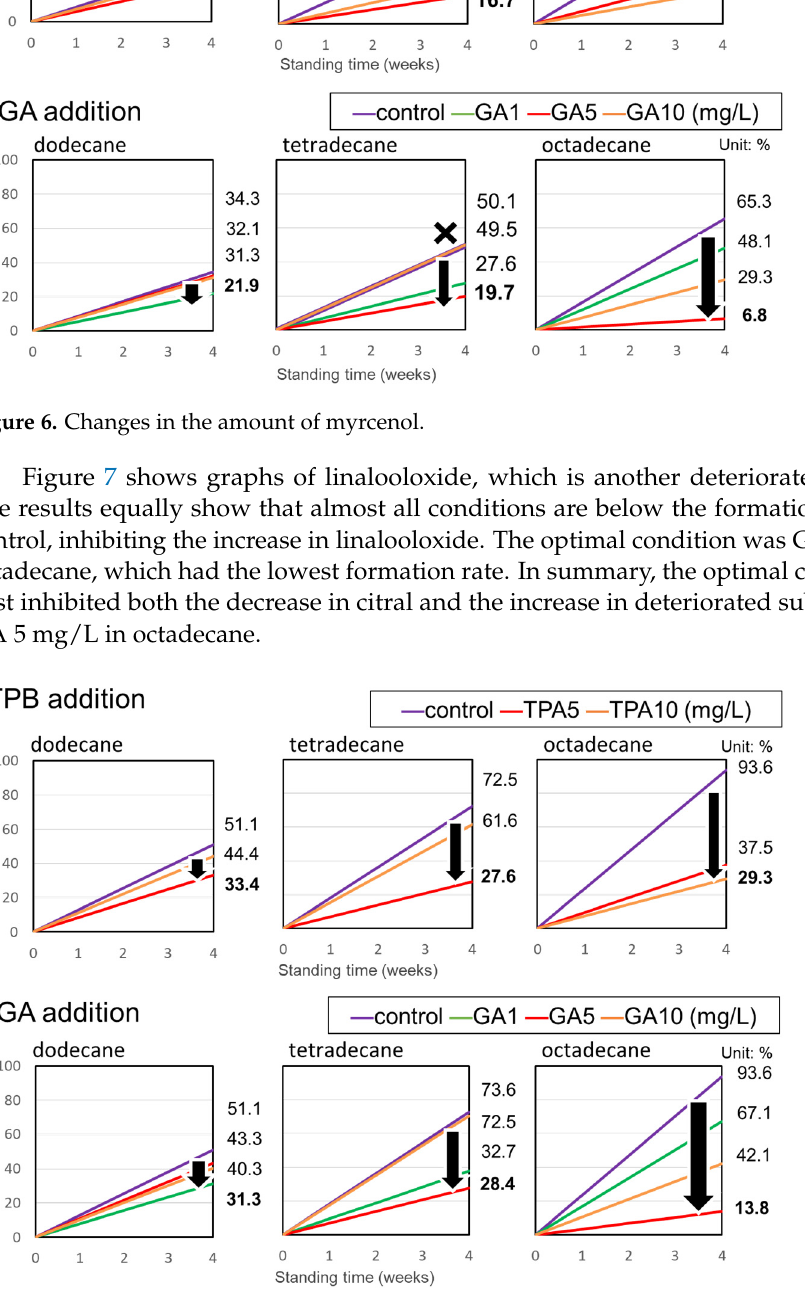
Figure 7. Changes in the amount of